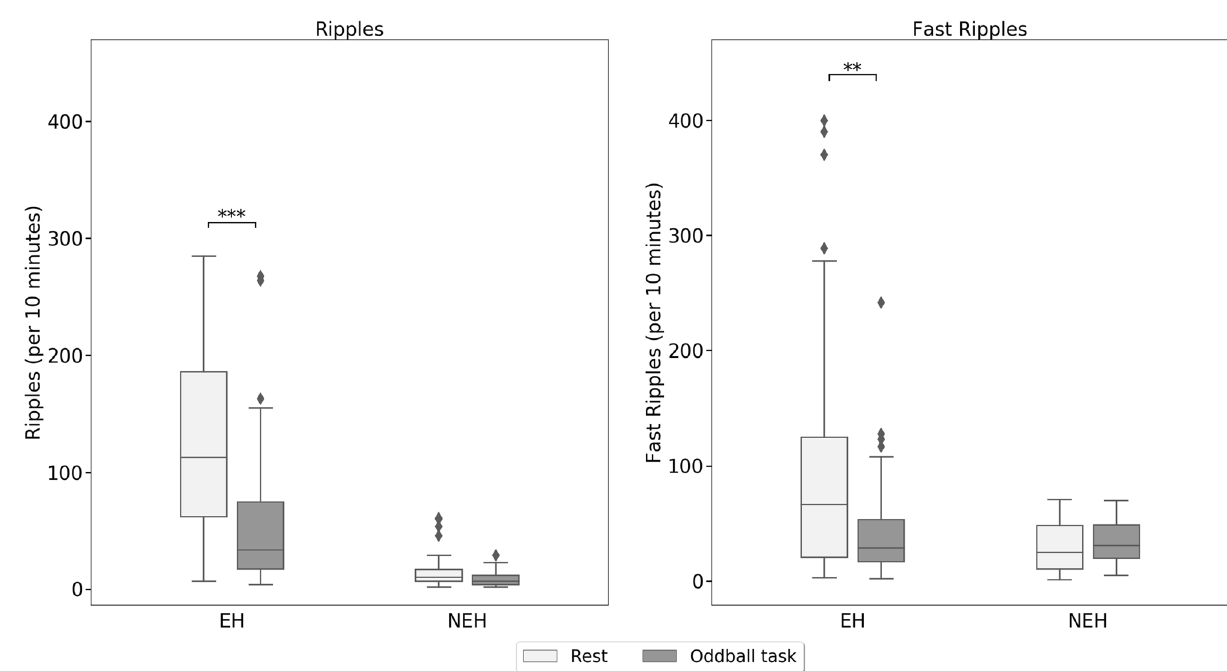
Figure 2. Fast ripple and ripple rates during resting and cognitive-task periods within the epileptic and non- epileptic hippocampi across all investigated subjects. Black asterisks indicate significant differences in epileptic hippocampi ( p < 0.001). Black diamonds indicate